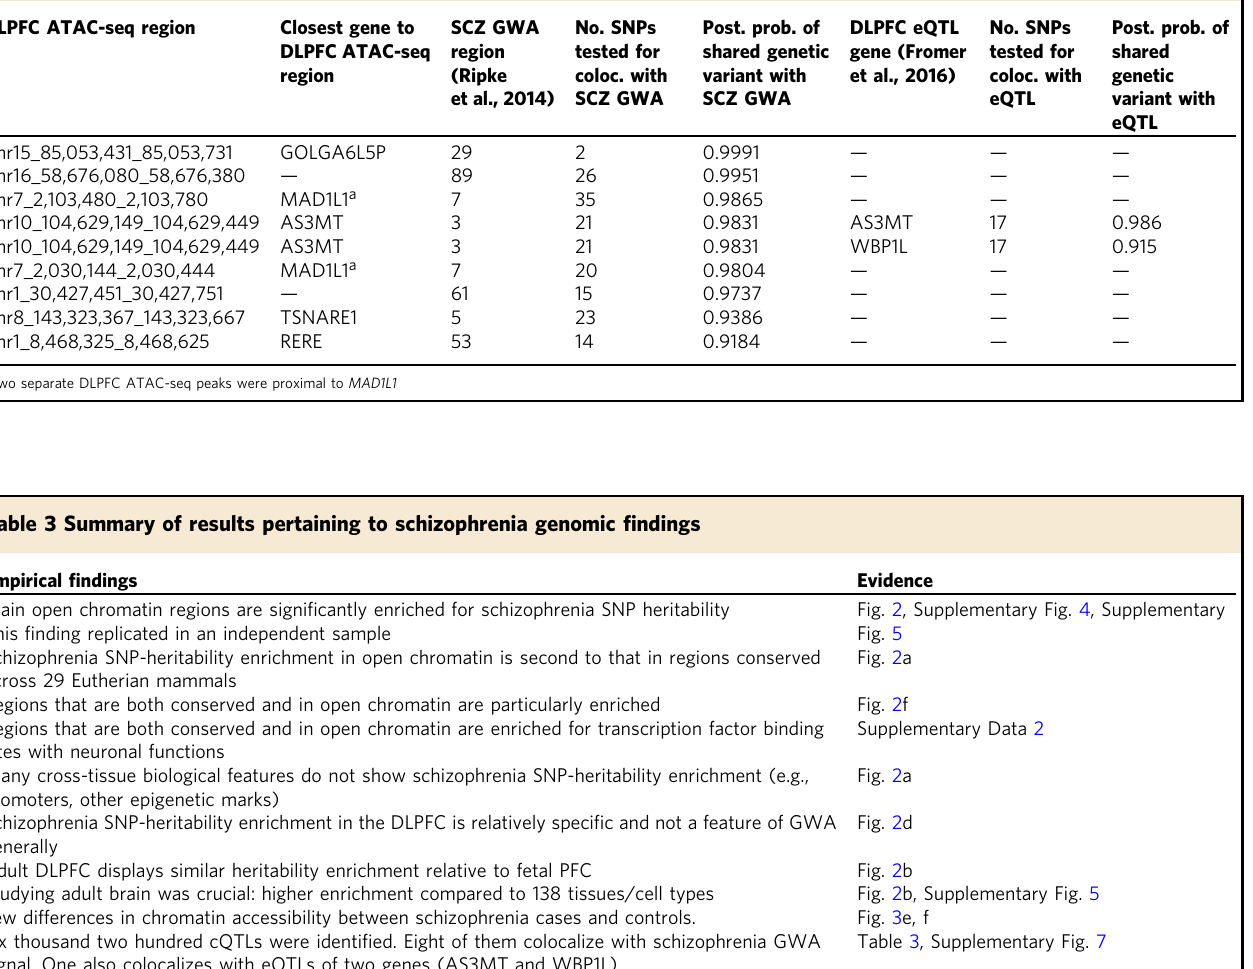
Studying adult brain was crucial: higher enrichment compared to 138 tissues/cell types Fig. 2b, Supplementary Fig. 5 Few differences in chromatin accessibility between schizophrenia cases and controls. Fig. 3e, f Six thousand two hundred cQTLs were identi fi ed. Eight of them colocalize with schizophrenia